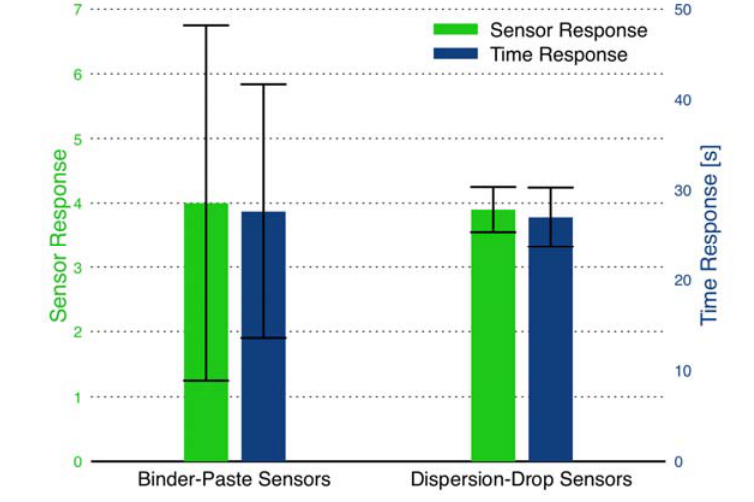
Figure 10. Comparison of sensor response and time response between binder-paste (TEOS-based recipe) and dispersion-drop film deposition methods. The error bars represent the variability in the response of several sensors prepared using each method - in other words, sensor